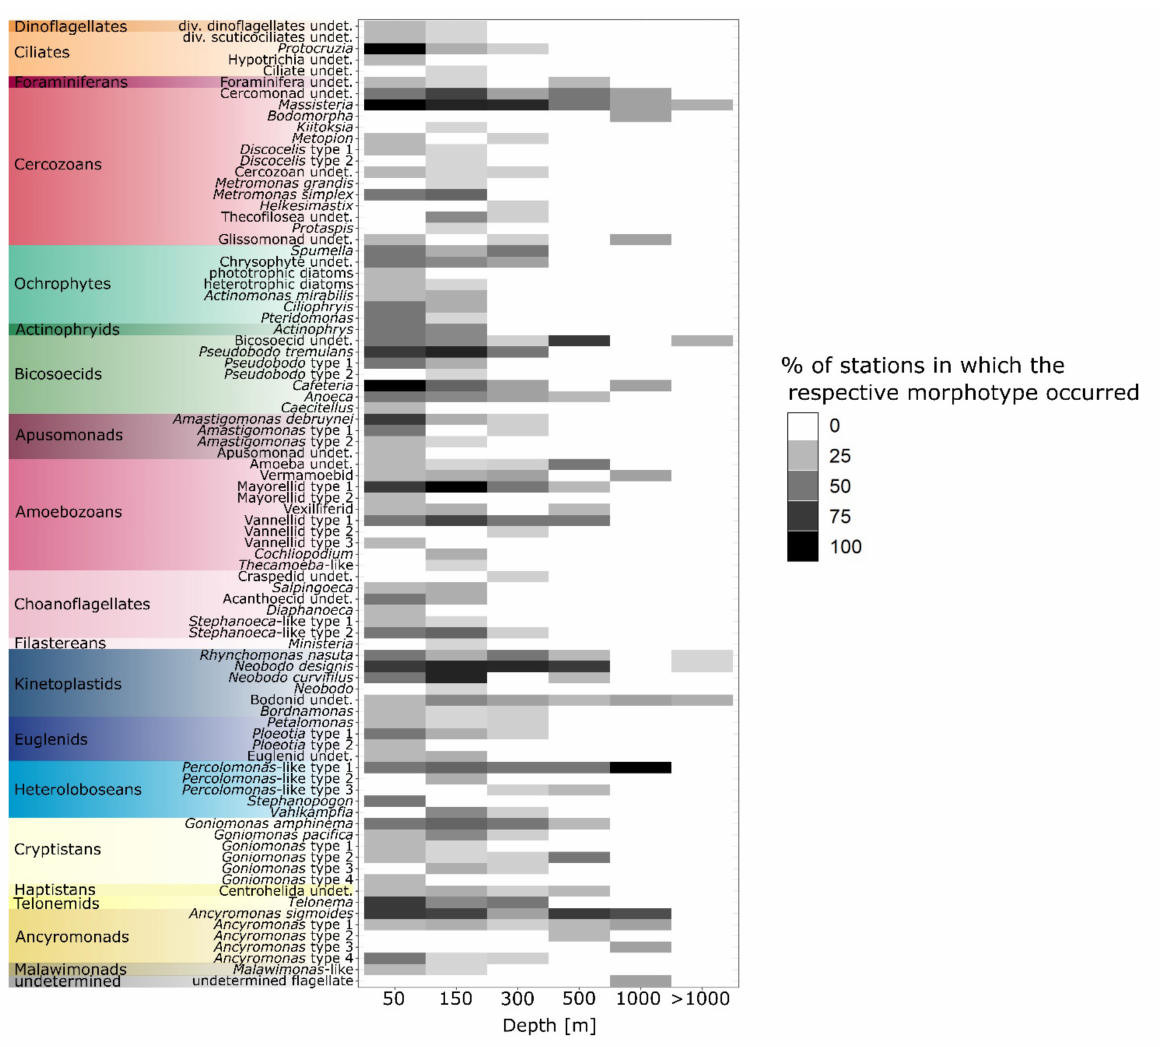
Figure 5. Heatmap indicating the percentage of samples for each depth in which the respective morphotypes appeared in cultures (depths from 1500 to 3000 m were pooled). The shade of grey indicates the percentage (see